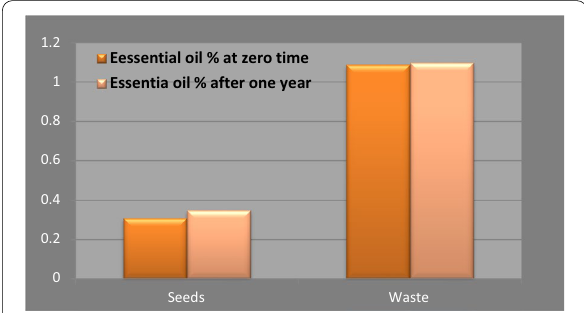
Fig. 1 Comparison of percentage of the essential oil of dry seeds and dry waste of Coriandrum sativum plant